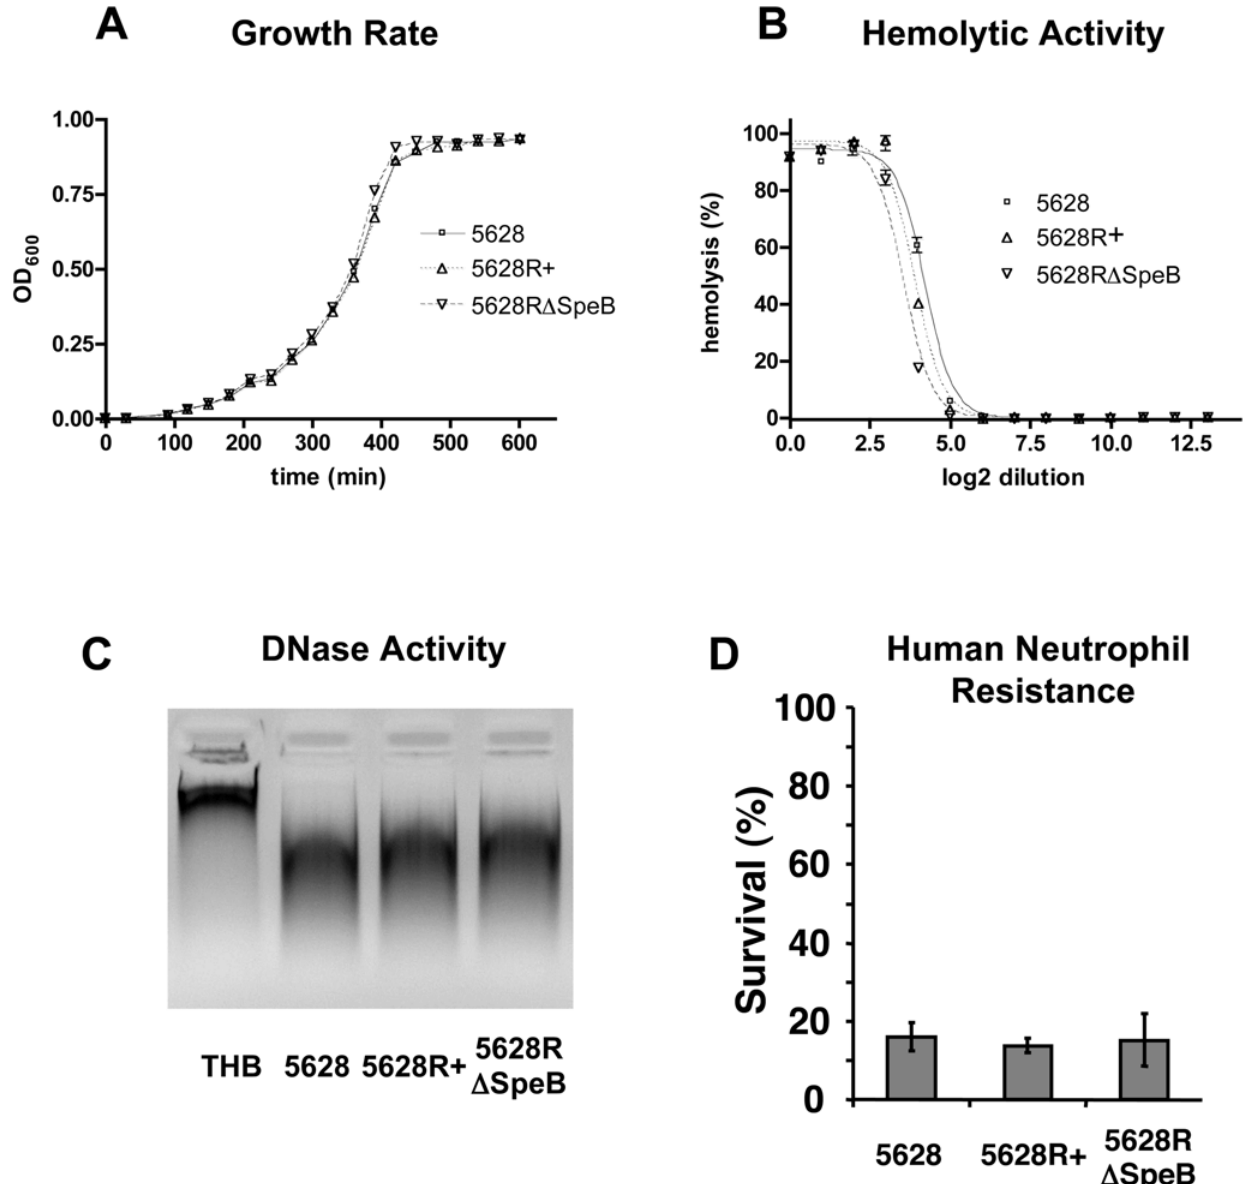
Figure 2. RopB mutation does not affect invitro growth, hemolytic activity, extracellular DNase activity or resistance to neutrophil killing. (A) OD 600 of in vitro grown bacterial cultures in THB. (B) Hemolysis of red blood cells by bacterial culture supernatants. (C) Degradation of calf thymus DNA by bacterial culture supernatants, run on a 1% agarose gel. (D) Bacterial survival after 30 min incubation with human neutrophils.